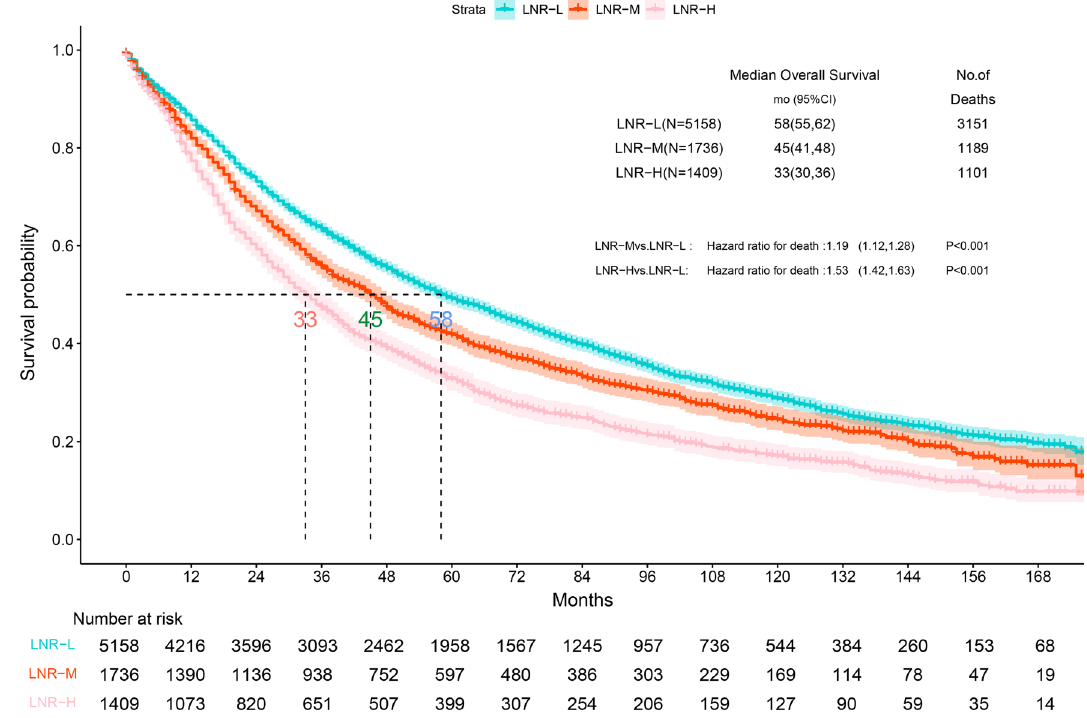
Fig. 5 Kaplan–Meier survival curves for stage LNR-L patients versus stage LNR-M patients and stage LNR-H